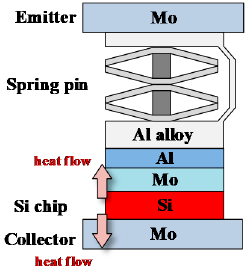
Figure 5. Single chip assembly.